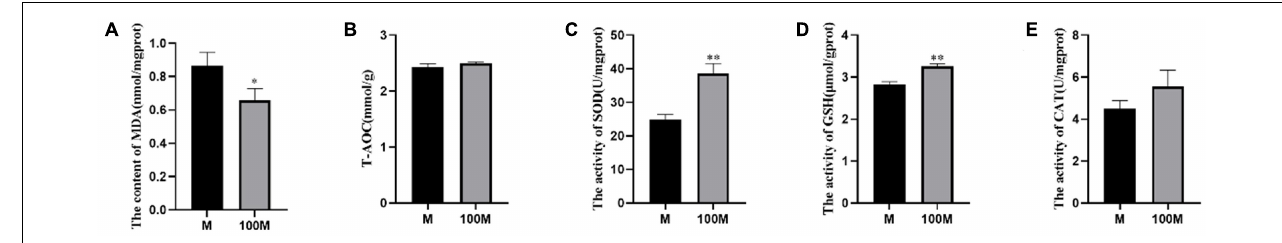
FIGURE 1 | Malondialdehyde (MDA) and antioxidant enzyme activity. (A) MDA (B) T-AOC (C) SOD (D) GSH, and (E) CAT. Data are expressed as means ± SD ( n = 3). ∗ < 0.05, ∗∗ < 0.01 compared to the control group.